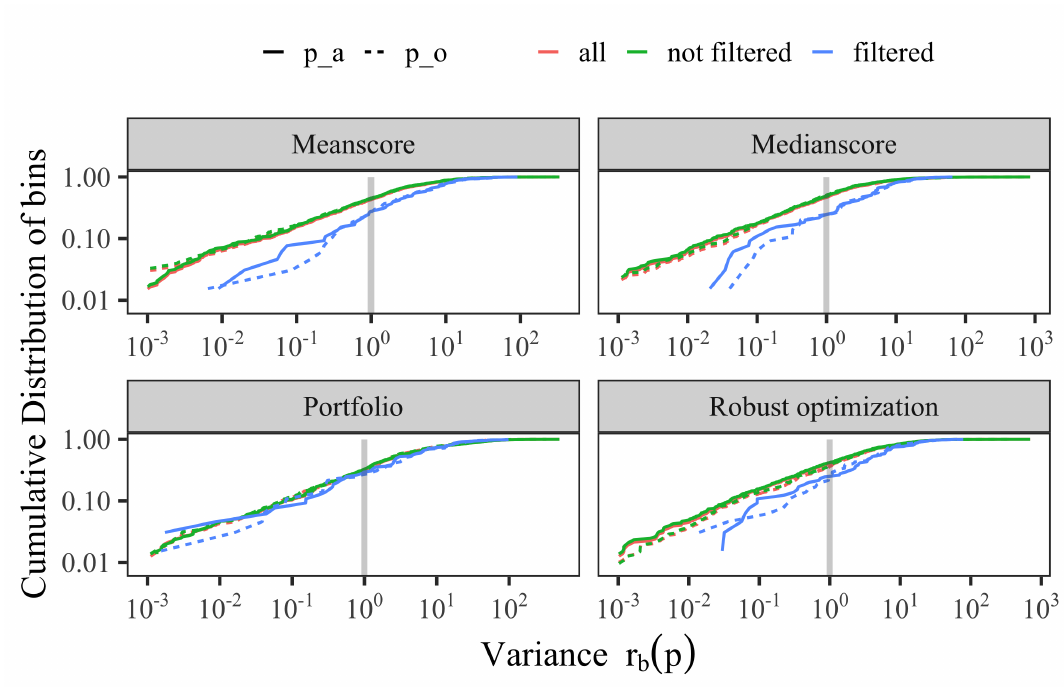
Figure 15: Same as Figure 14, but using observable